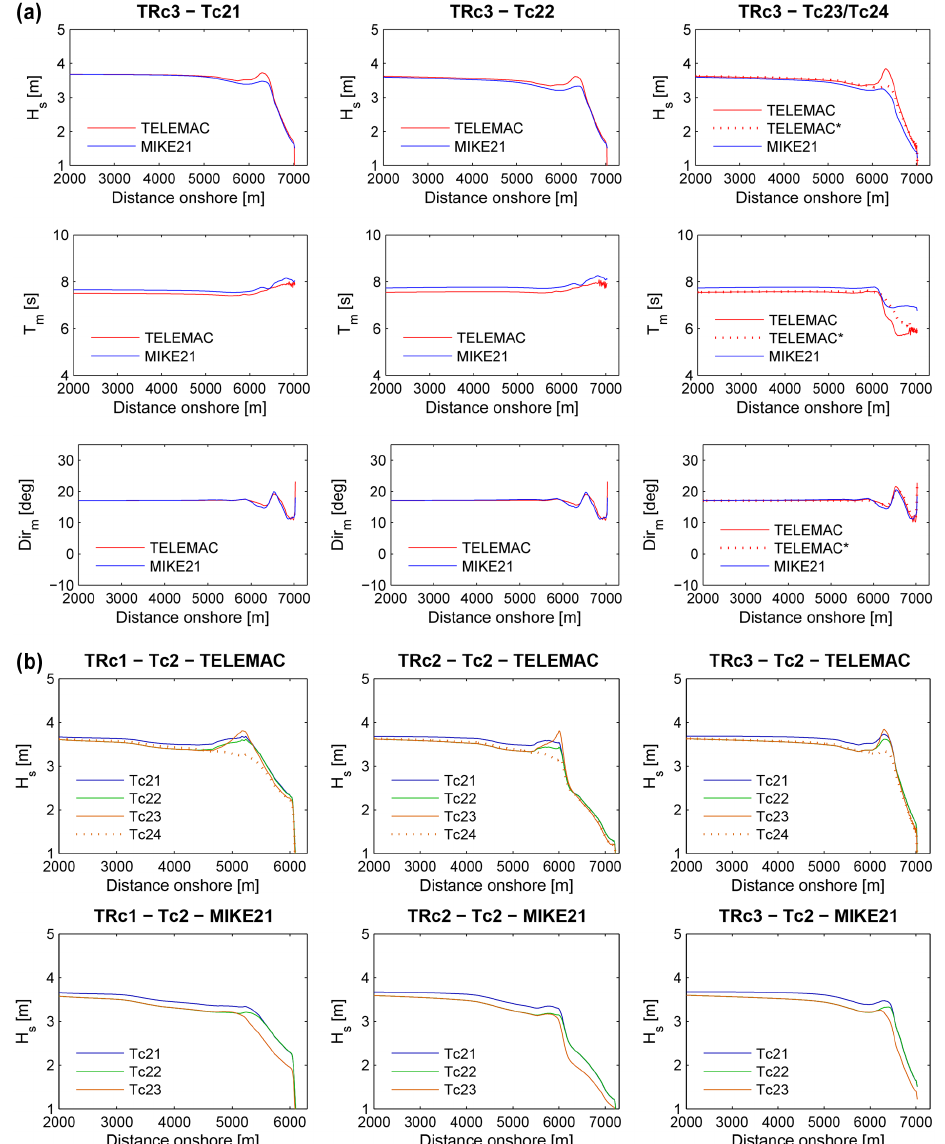
Figure 8. (a) Comparison of TELEMAC and MIKE21 results ( H s − T m − Dir m ) along transect TRc3 for the Brindisi–Torre Guaceto case study (forcing WE2; ∗ = Tc24); (b) effect of different processes on H s for TELEMAC (top) and MIKE21